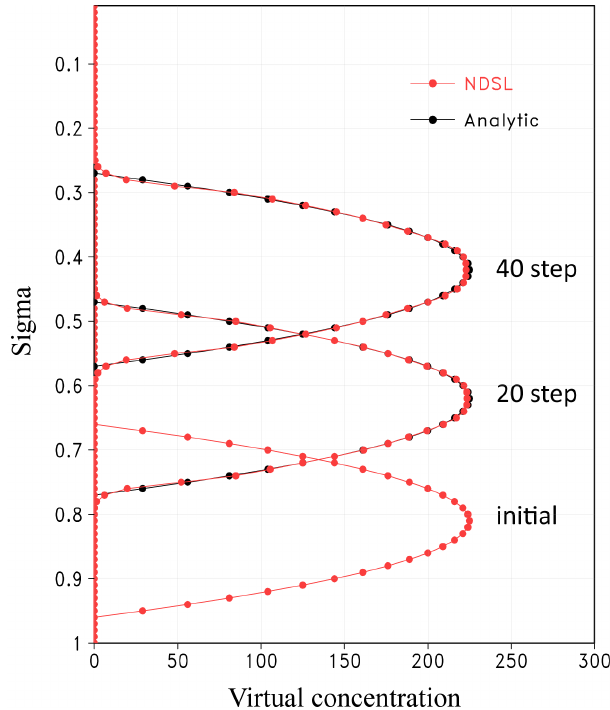
Figure 4. Virtual concentration from the idealized vertical advec- tion experiment. The red and black lines indicate the transported concentration by the NDSL and the analytic solution,